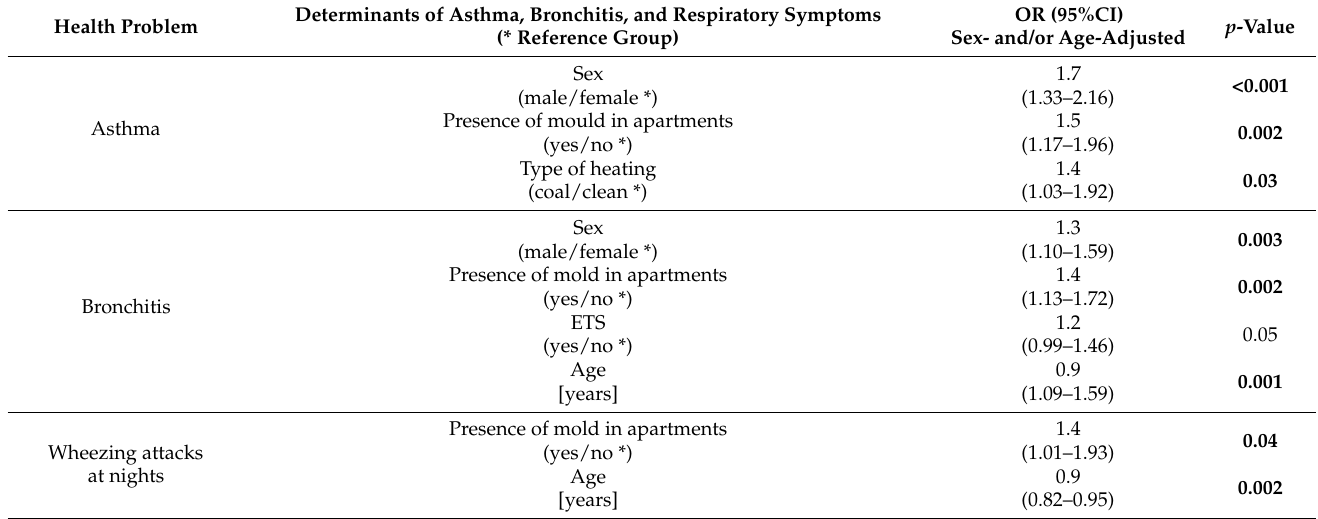
Table 2. Adjusted odds ratios (OR) and 95% confidence intervals related to determinants of observed respiratory